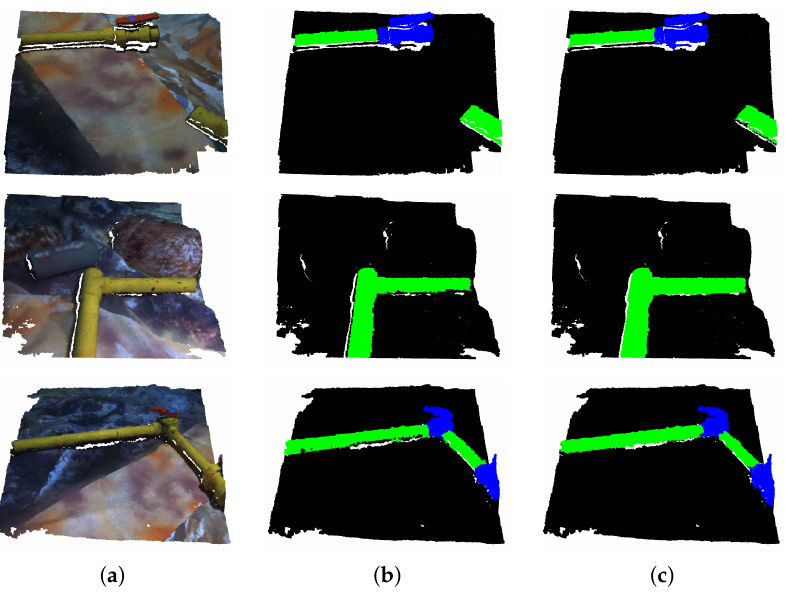
Figure 8. Qualitative results for the Pool test set. ( a ) original point cloud, ( b ) ground truth annotations, ( c ) network